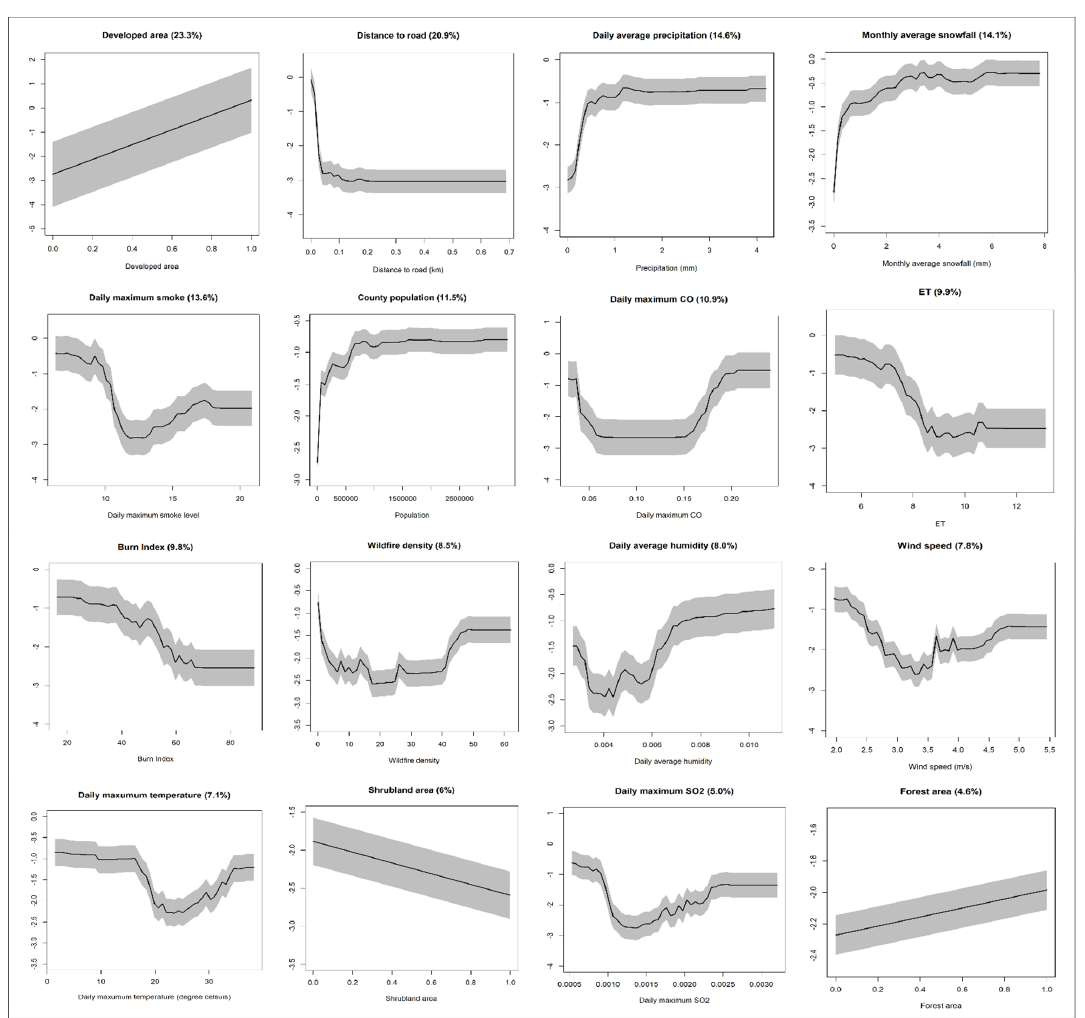
Figure 3. Partial dependency plots of covariates used in the RF model to estimate the spatial distribution of the mortality of Wilson’s Warbler. The gray shading area indicates the confidence intervals derived from the model iterations. We report the mean decrease accuracy for each of the variables in the